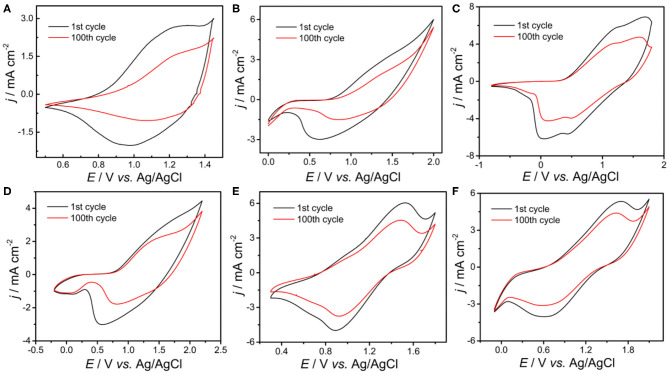
CVs of PDBT-Th (A), PDBT-Th:Th (B), PDBT-2Th (C), PDBT-Th:2Th (D), PDBT-2Th:Th (E), and PDBT-2Th:2Th (F) cycled 100 times at a potential scan rate of 200 mV s−1 in monomer-free CH2Cl2-Bu4NPF6 (0.10 mol L−1).